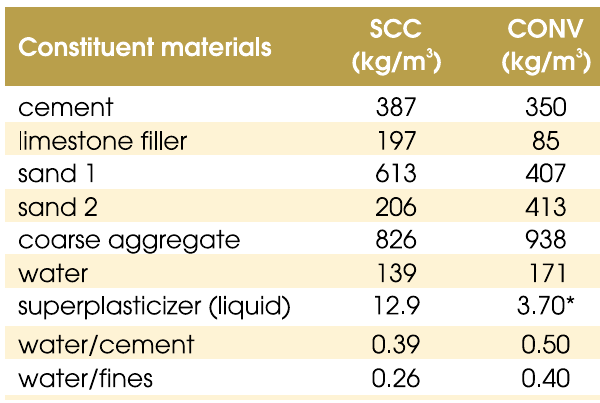
S. NUNES | H. FIGUEIRAS | J. SOUSA COUTINHO | J. FIGUEIRAS